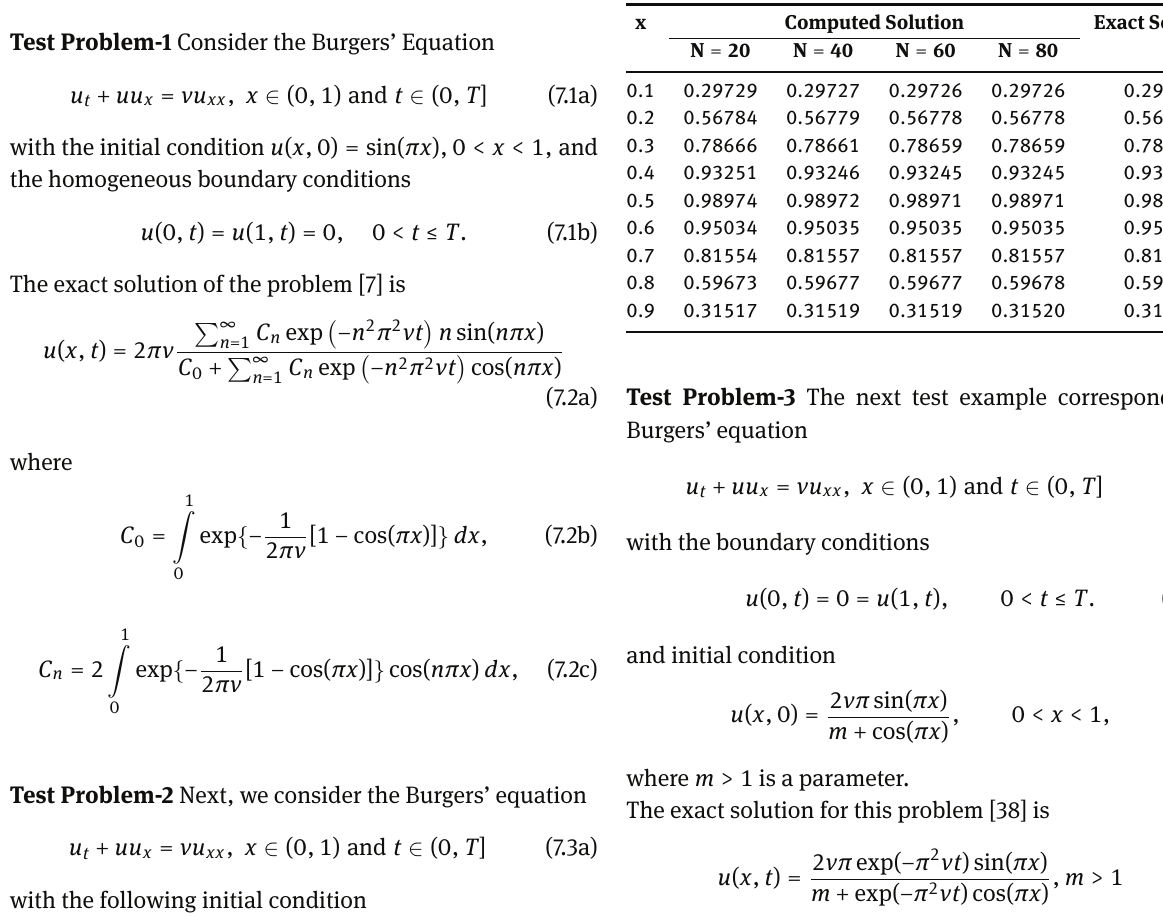
Table 1: Comparison of the Numerical solution with the exact solu- tion at different space points of example-1 at T = 0.01 for ν = 0.1 and Δt = 0.0001 .